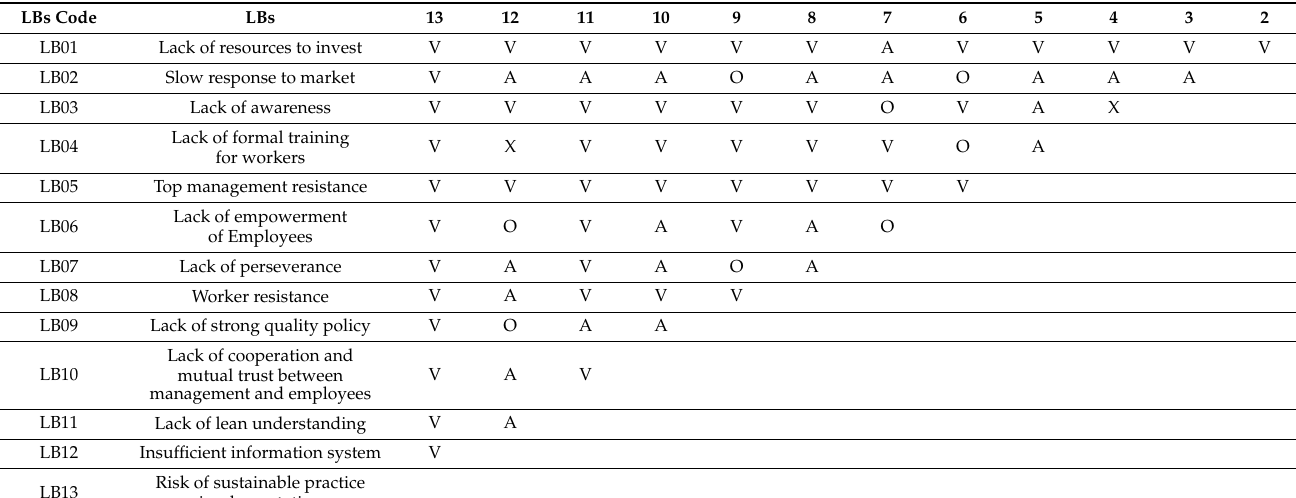
Table 4. Structural self-interaction matrix (SSIM).